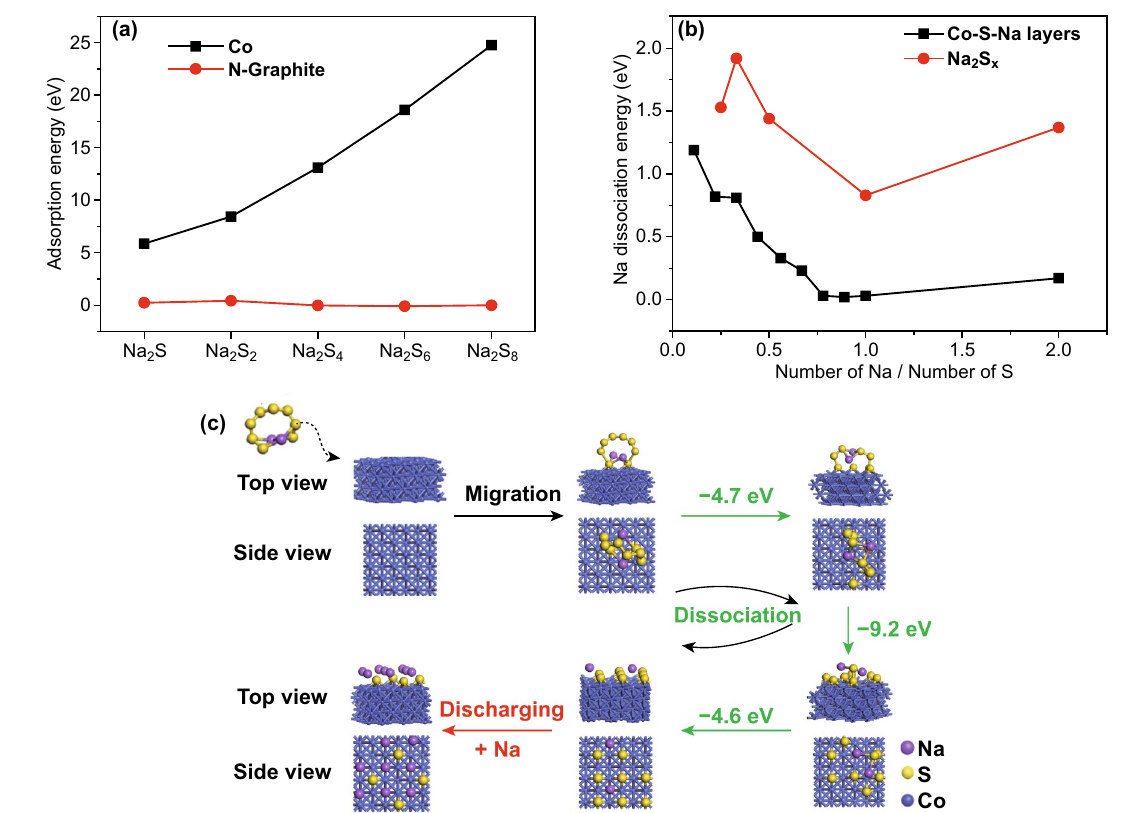
Fig. 4 a Calculated adsorption energy (eV) for the most favorable adsorption configuration of Na 2 S x at Co (111) surface and N‑doped graphite at the DFT level. b Dissociations for the layered Co–S–Na structures and free Na 2 S x , x = 1–8. c Conversion between the molecularly adsorbed Na 2 S 8 to the dissociatively adsorbed Na2S8 at the Co (111) surface via S migration and embedded